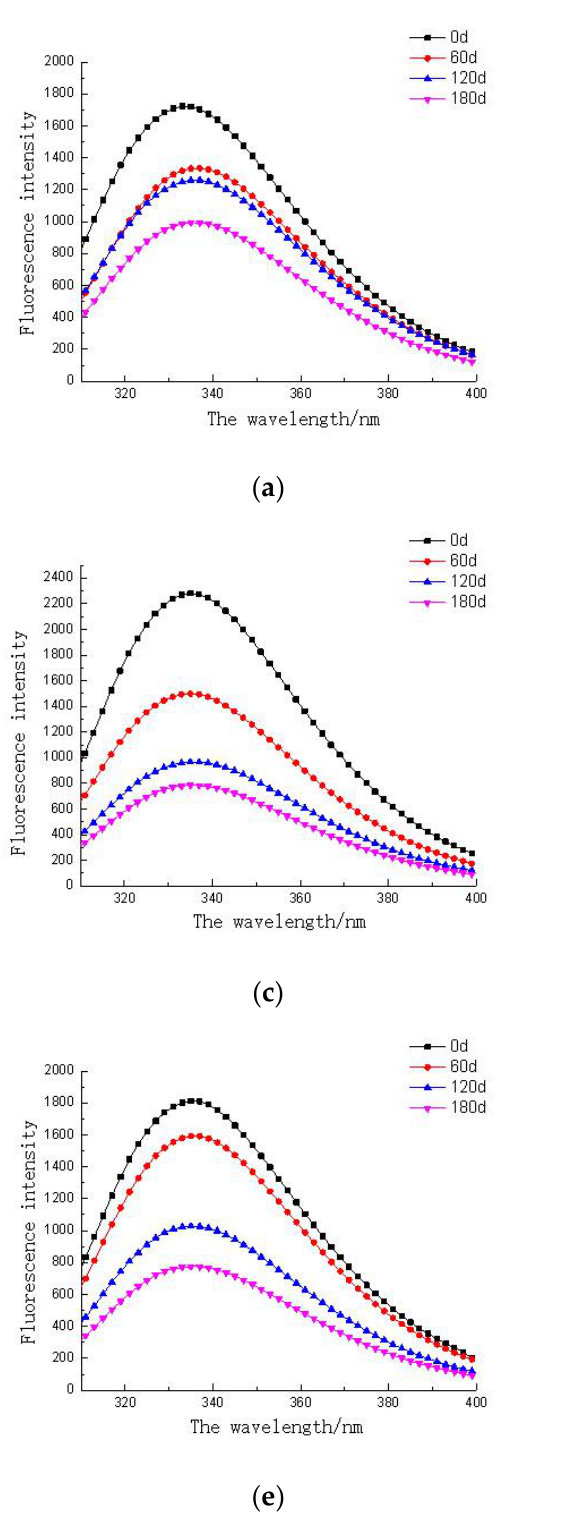
Figure 5. Changes in endogenous fluorescence intensity of tuna in different parts during frozen storage at different temperatures ( a ) frozen storage at −18 °C ( b ) frozen storage at −18 °C ( c ) frozen storage at −18 °C ( d ) frozen storage at −55 °C ( e ) frozen storage at −18 °C ( f ) frozen st orage at −55 °C).